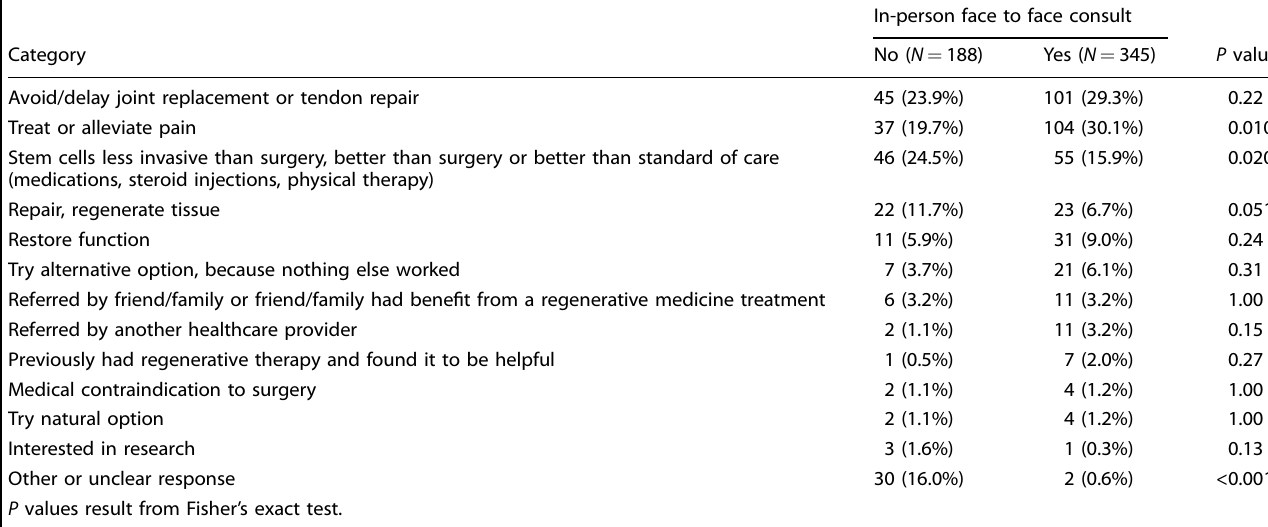
Table 2. Comparison of reasons why patients reported that they were interested in a SCT for their condition according to whether they had an in- person